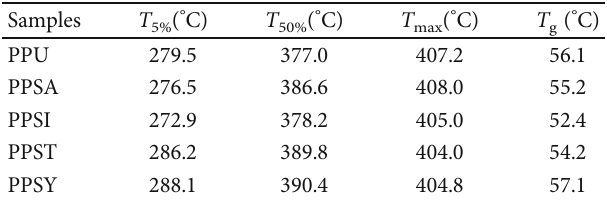
Table 1: The thermal